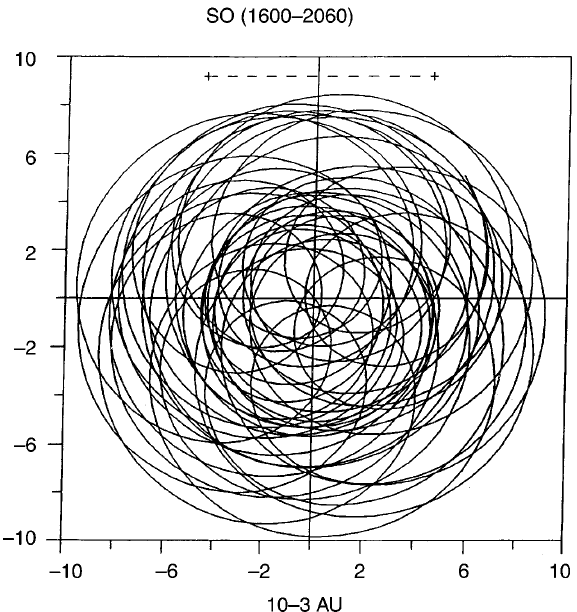
Fig. 1. The orbit of the centre of the Sun around the centre of mass of the solar system (in units of 10 ) 3 AU, astronomical unit = 149 Æ 10 6 km), for further details see Fig. 2. The dashed horizontal abscissa in the upper part of the figure represents the diameter of